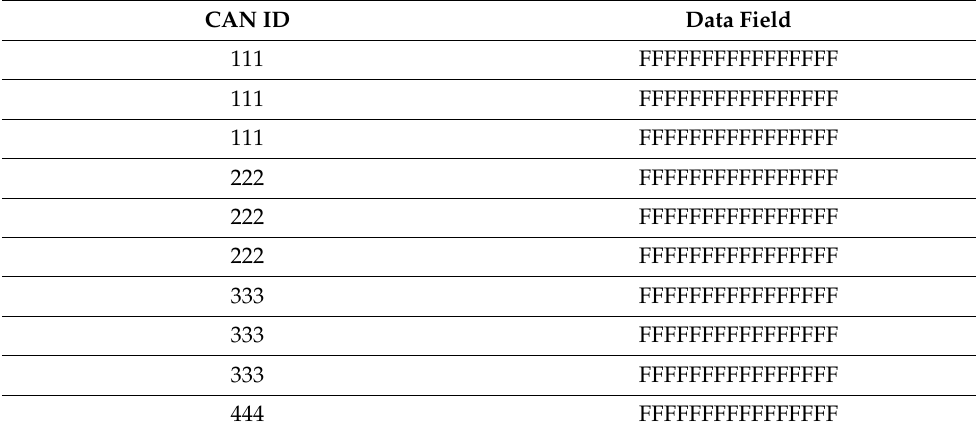
Table 1. Fuzzing messages injected by the authors